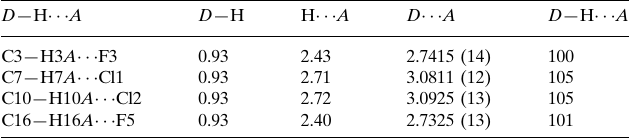
Hydrogen-bond geometry (A˚ , (cid:3)